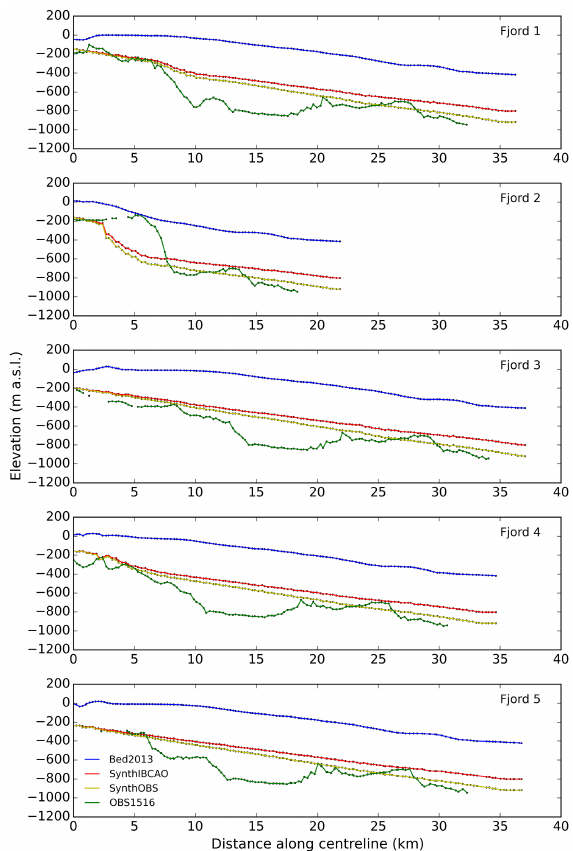
Figure 12. Centreline elevation profiles from Bed2013, OBS1516 and the SynthIBCAO and SynthOBS synthetic algorithm ap- proaches. All profiles extend from the head of each fjord to the mouth as depicted in Fig. 3.